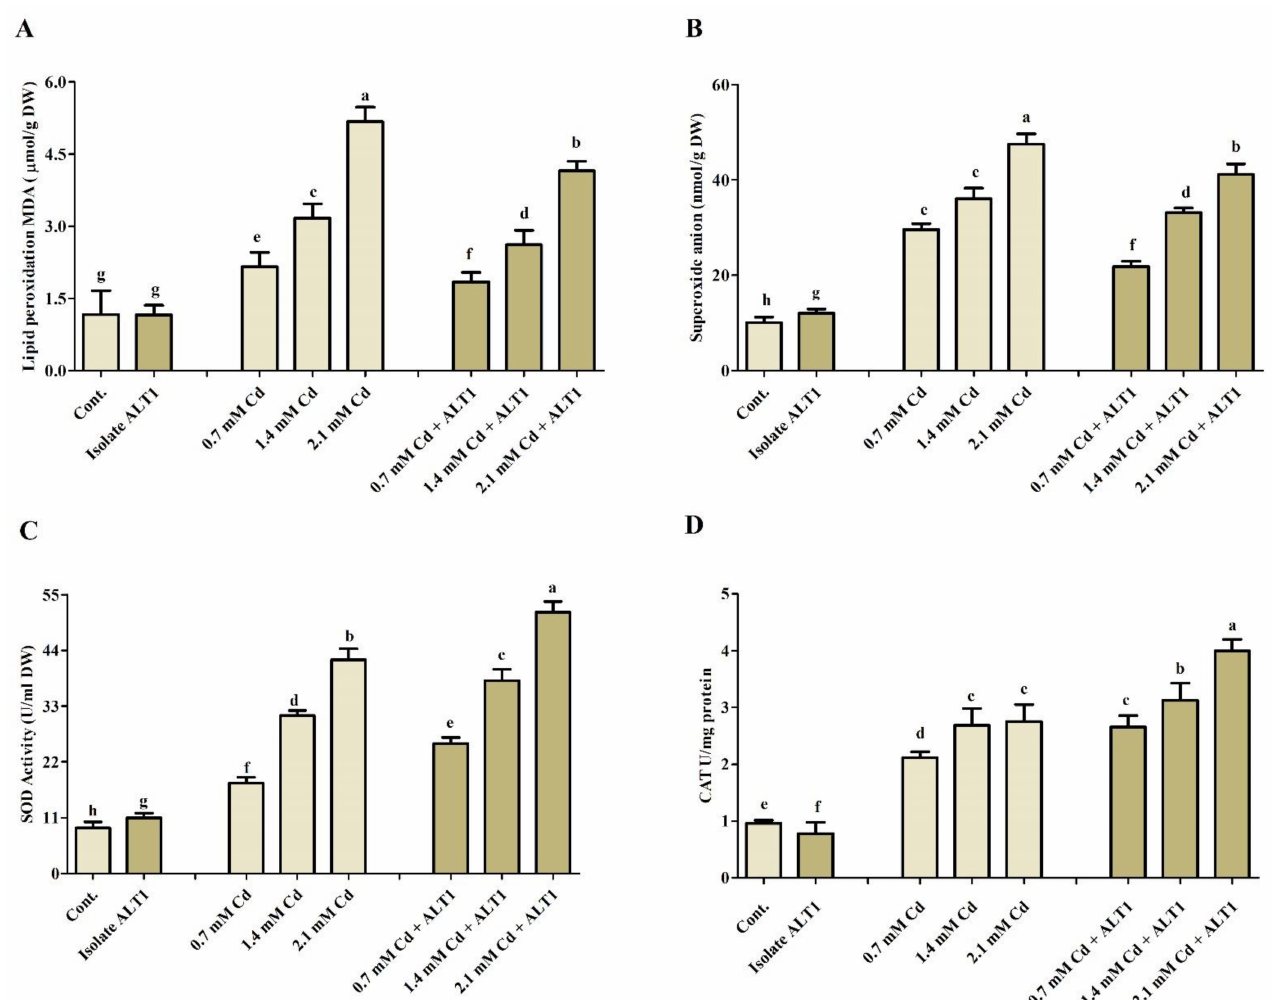
Figure 4. The effect of Cd stress on different antioxidant components of ALT1-inoculated and non-inoculated soybean plants. ( A ) MDA (lipid peroxidation); ( B ) SOA (superoxide anions); ( C ) SOD (superoxide dismutase), and ( D ) CAT (catalase) contents in soybean plants grown under normal conditions and under Cd stress. Each data point is the mean of three replicates. Error bars represent standard errors. The bars presented with different letters are significantly different from each other as evaluated by Duncan’s multiple range